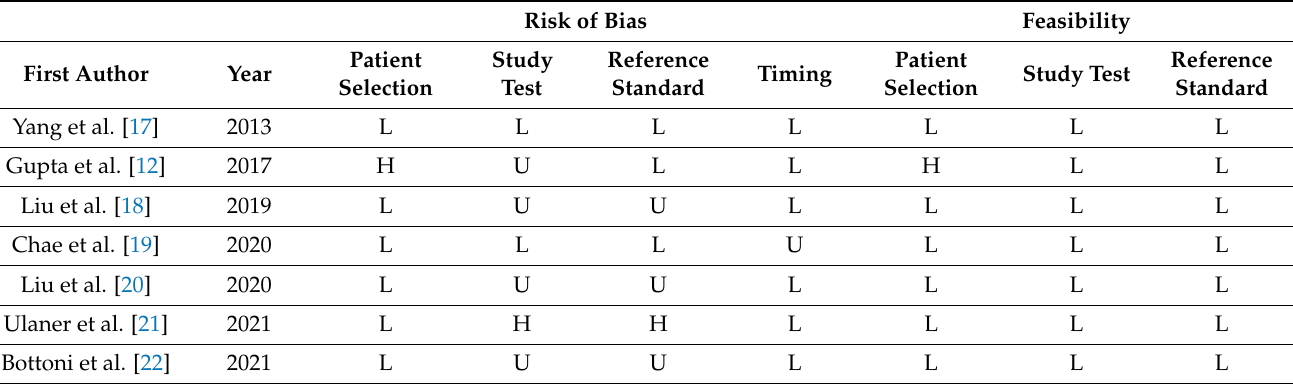
Table 4. Quality assessment of the studies and risk of bias in each study